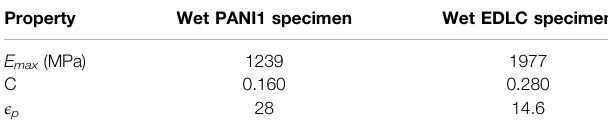
TABLE 1 | Optimised Piece-wise model constants.